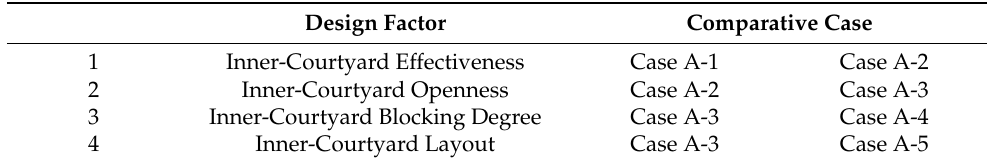
Table 7. Research design factor and corresponding cases.